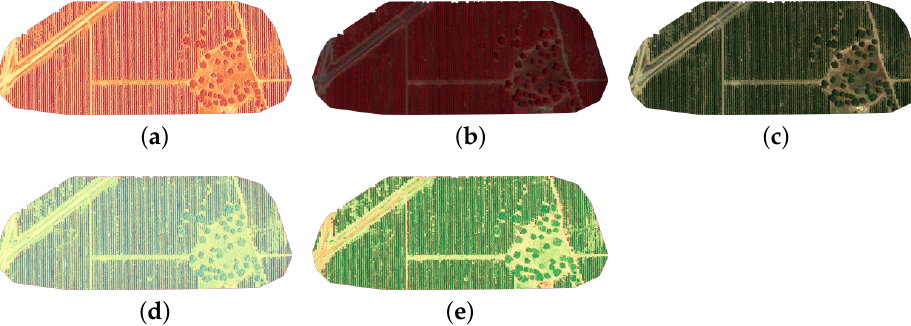
Figure 1. Different image types of the same map. This figure includes the multispectral indices used (figures ( a , d , e )) and the color image formats (figures ( b , c )). ( a ) NDWI, ( b ) CIR, ( c ) RGB, ( d ) NDRE, and ( e )